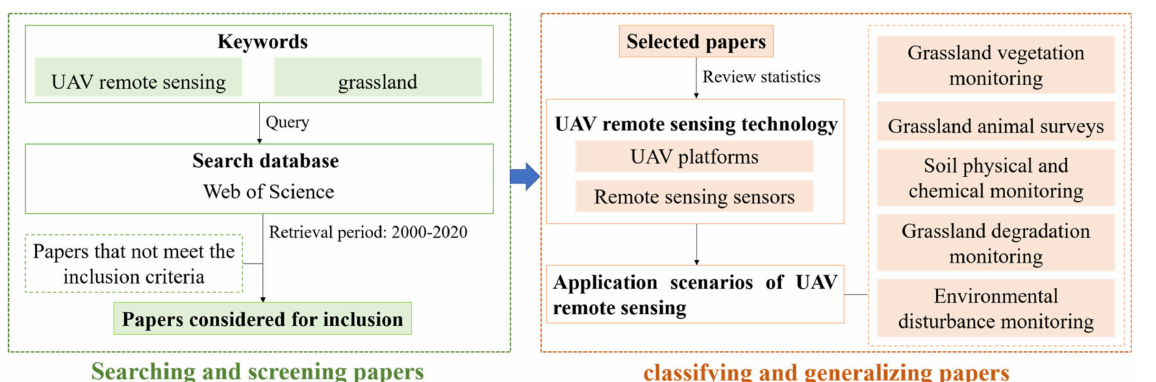
Figure 1. The flowchart of the paper